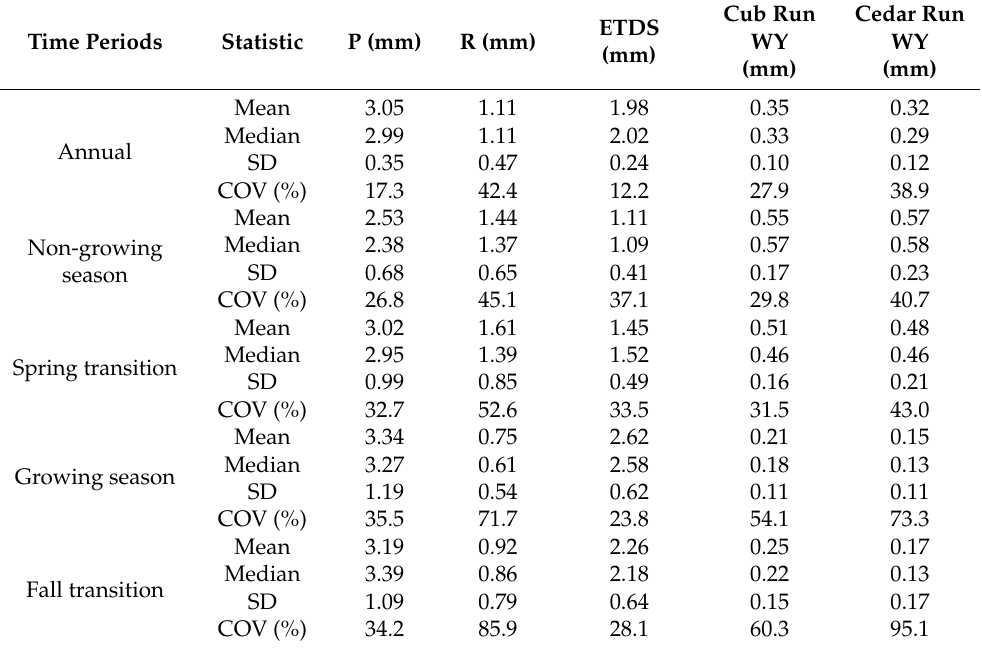
Table 5. Statics for seasonal variability of precipitation (P), runoff (R), evapotranspiration plus change in storage (ETDS), and water yield (WY) for Cub watershed (Data source; [133]).